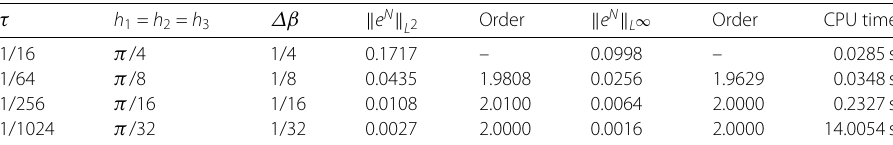
Table 6 Errors and convergence orders of scheme (59)–(61) with an optimal step size ratio for τ , h 1 , h 2 , h 3 and Δβ (Example